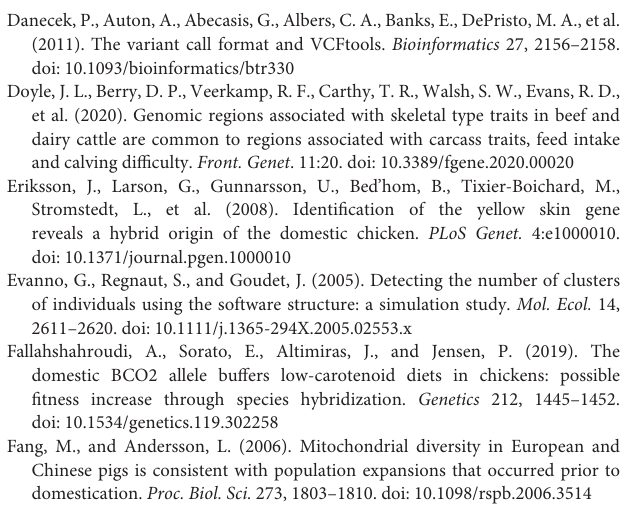
Supplementary Table 4 | Common significantly selective regions of Henan indigenous pigs. Supplementary Table 5 | Genes located in the common selective regions of Henan indigenous